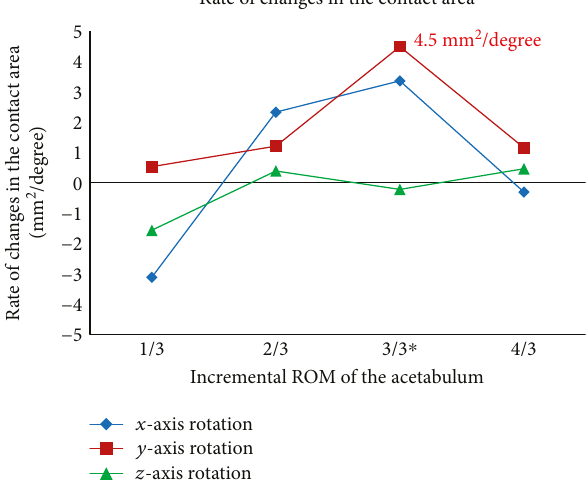
Figure 6: Rate of change in the contact area as a function of incremental increased rotations of the acetabulum. The negative sign indicates a decrease in contact area. The “ ∗ ” sign indicates the actual acetabular rotation (ACR) during the surgery.